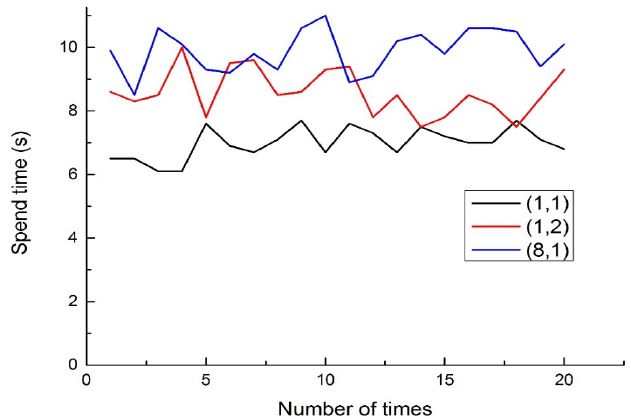
Figure 16. The experimental result of operation time for 20 inputs.